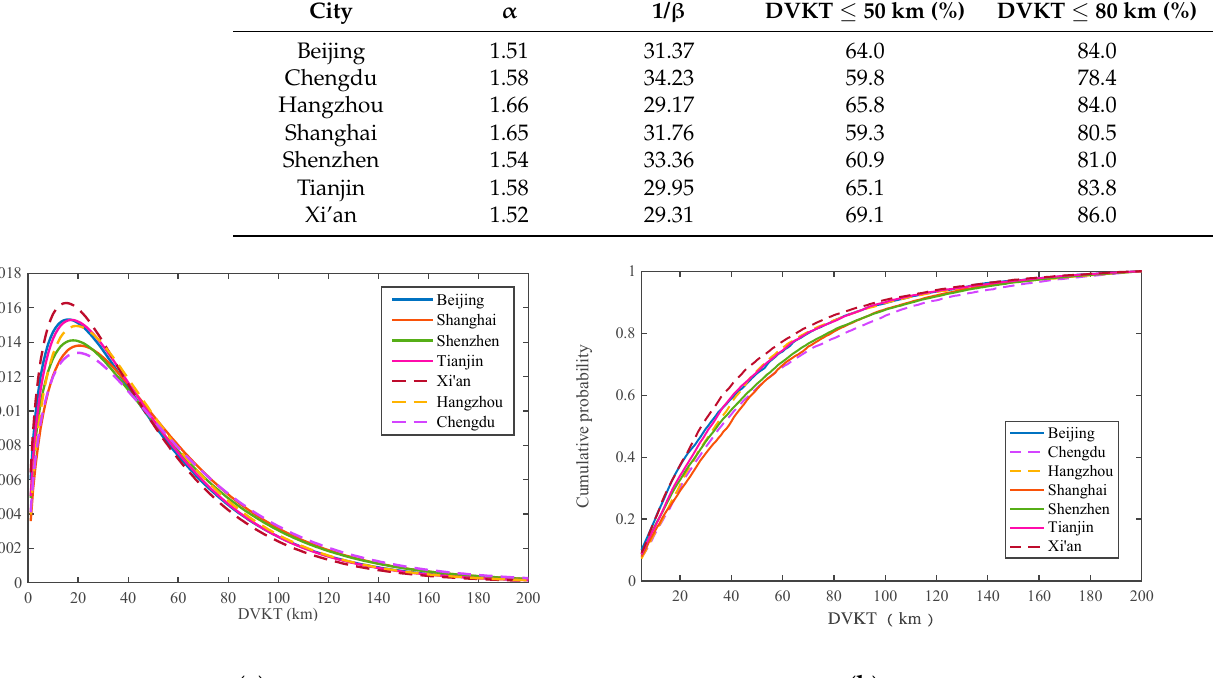
Figure 2. Fitted DVKT Gamma distribution ( a ) probability density distribution ( b ) cumulative probability density distri- bution.